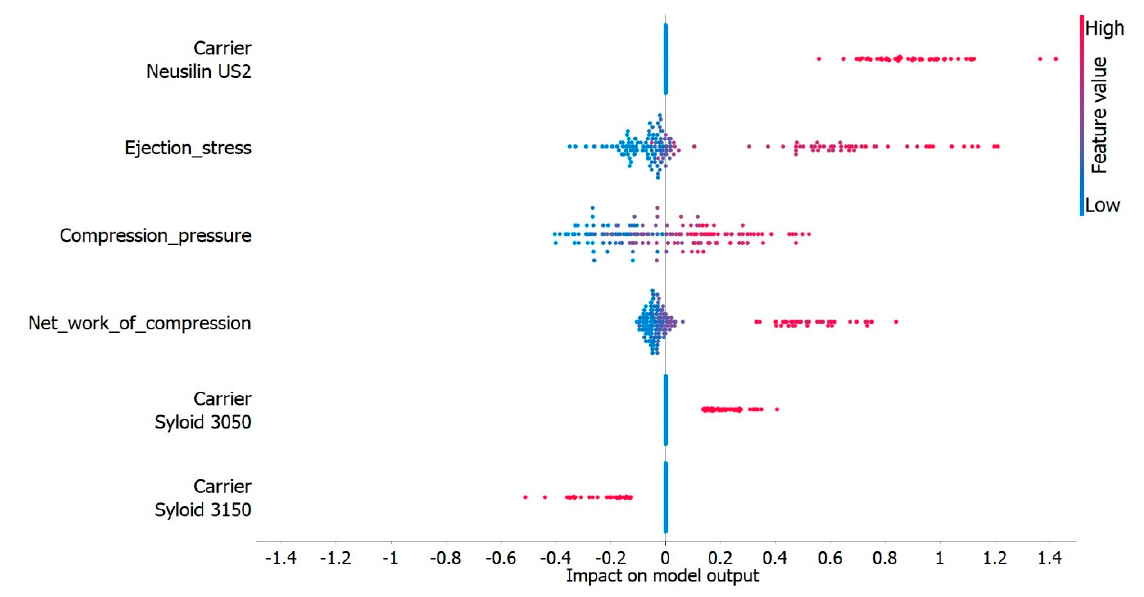
Figure 6. The impact of tested variables on regression model’s output.